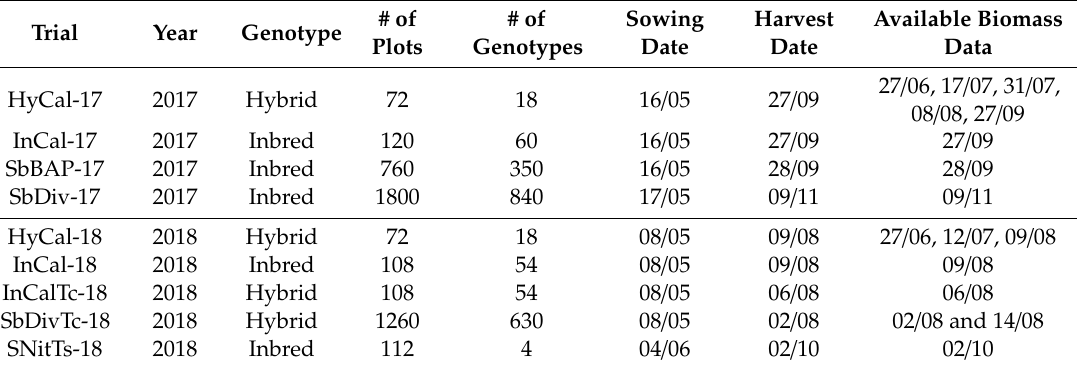
Table 1. Experiment designs for the 2017 and 2018 growing seasons.